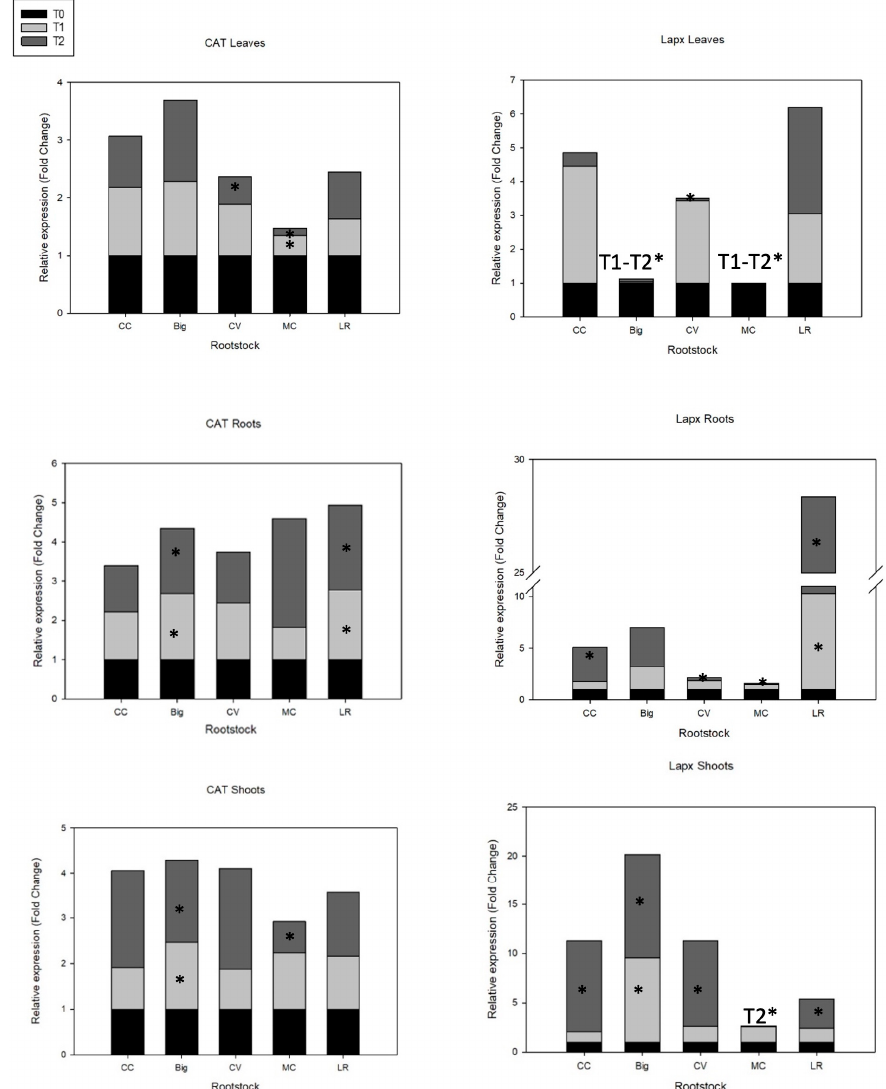
Figure 2. Expression profiles of APX and CAT genes of ‘Hernandina’ clementine ( Citrus clementina hort. ex Tanaka) (willowleaf mandarin ( C. deliciosa ) × sweet orange ( C. sinensis (L.) Osbeck)) grafted on 5 citrus rootstocks in response to salt. Big: sour orange ( C. aurantium L.); CC: Carrizo citrange ( C. sinensis × Poncirus trifoliata (L.) Raf); CV: Volkamer lemon ( C. volkameriana V. Ten. & Pasq.);